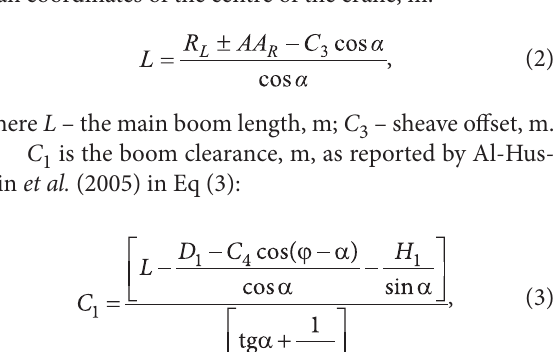
Fig. 3. Highlighting site boundaries and surrounding buildings